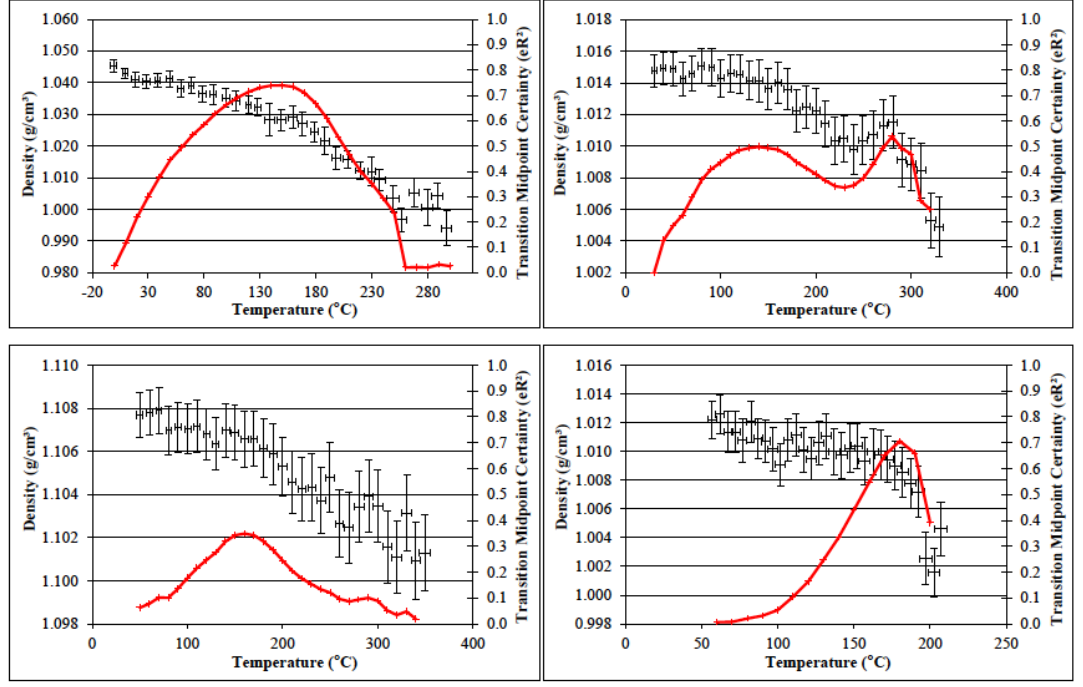
Figure 8. Plot of density vs. temperature of PBZs with TMC. PBA-a ( top left ), PBF-a ( top right ), PBT-a ( bottom left ), PBD-a ( bottom right ).